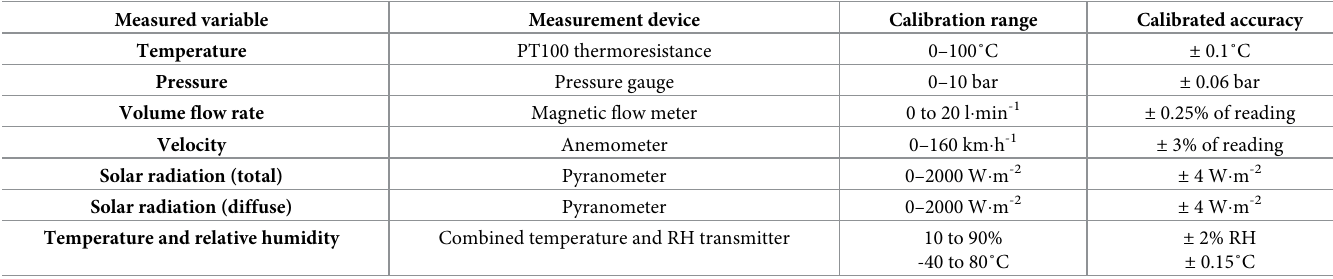
Table 2. Transducers installed in the